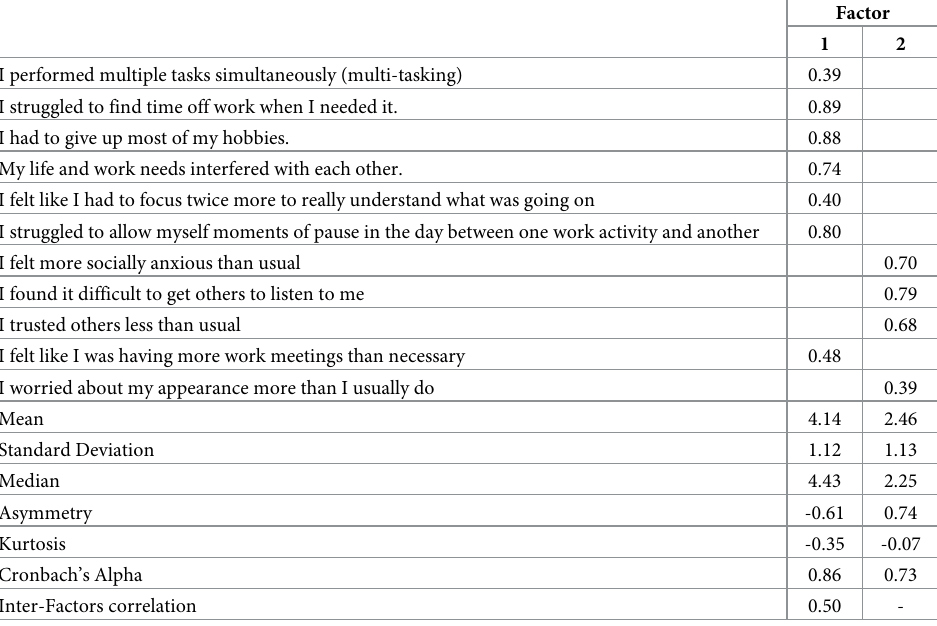
Table 3. Subsample 1 (n = 184): Factor loadings, descriptive statistics, Cronbach’s Alphas, and inter-scale correla- tion of Online Fatigue Scale (Off-Balance and virtual relations